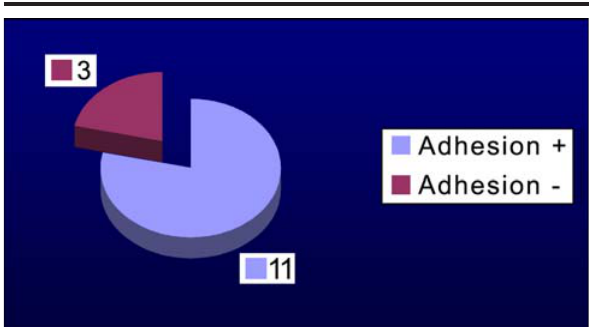
FIGURE 1 - Amount of adhesion formation to polypropylene mesh fixation.